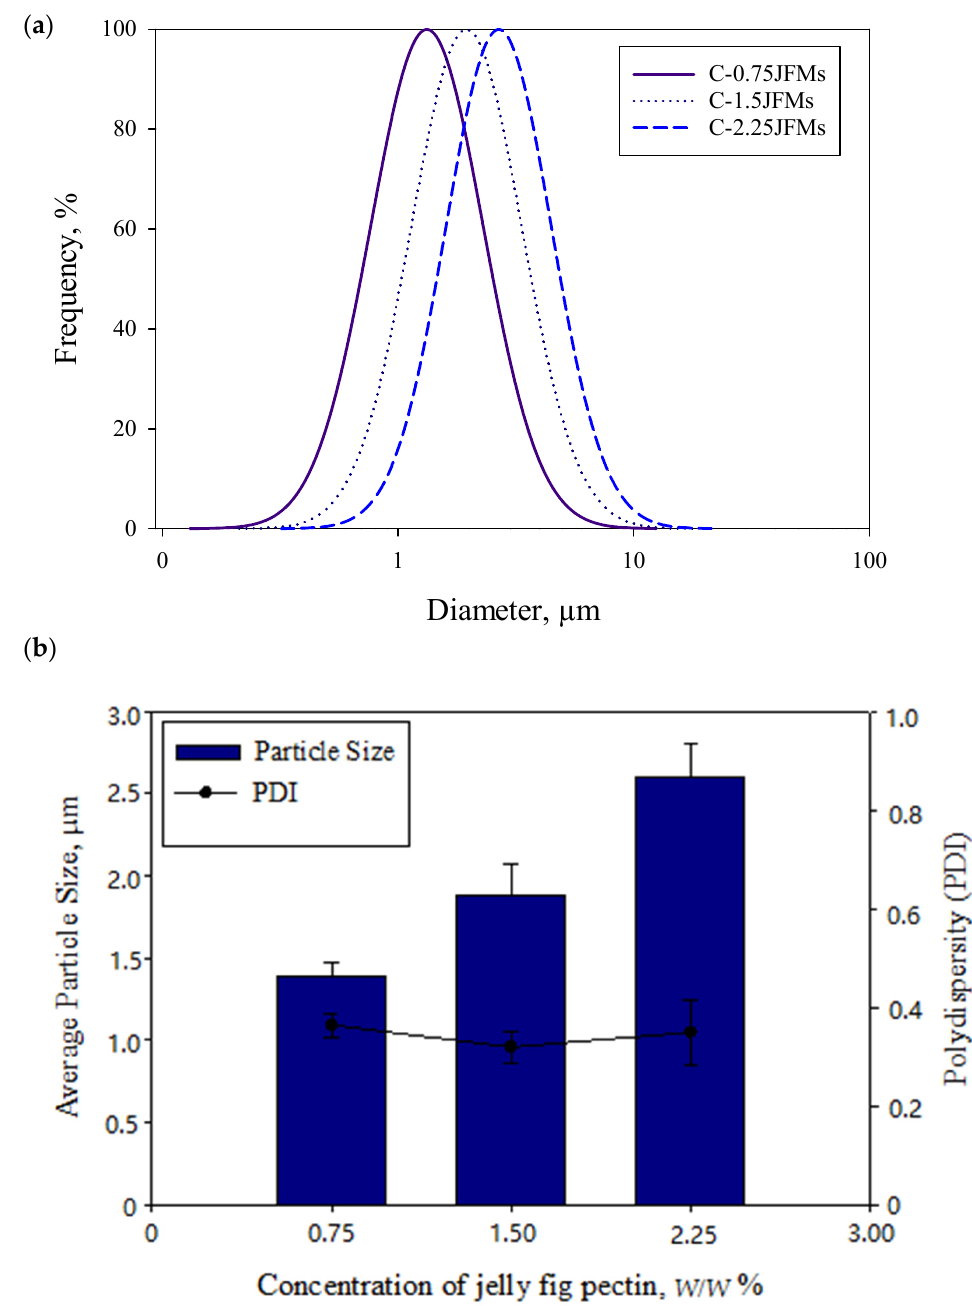
Figure 2. The size distribution of the emulsion, ( a ) the average diameter, and ( b ) polydispersity index before VSD.